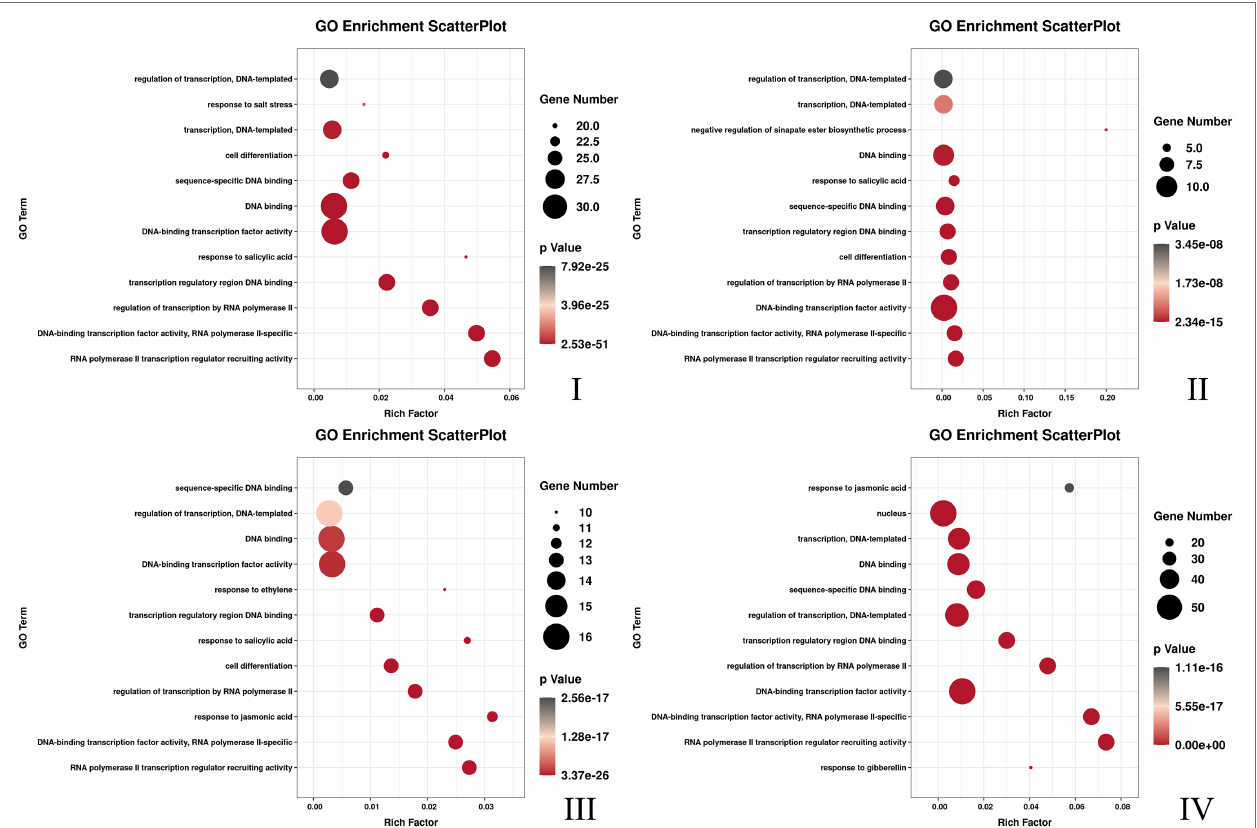
FIGURE 5 | The top 12 GO pathway with the most significant enrichment of each different DE MYBs expression trend. The I, II, III, and IV was corresponding to the Figure 4